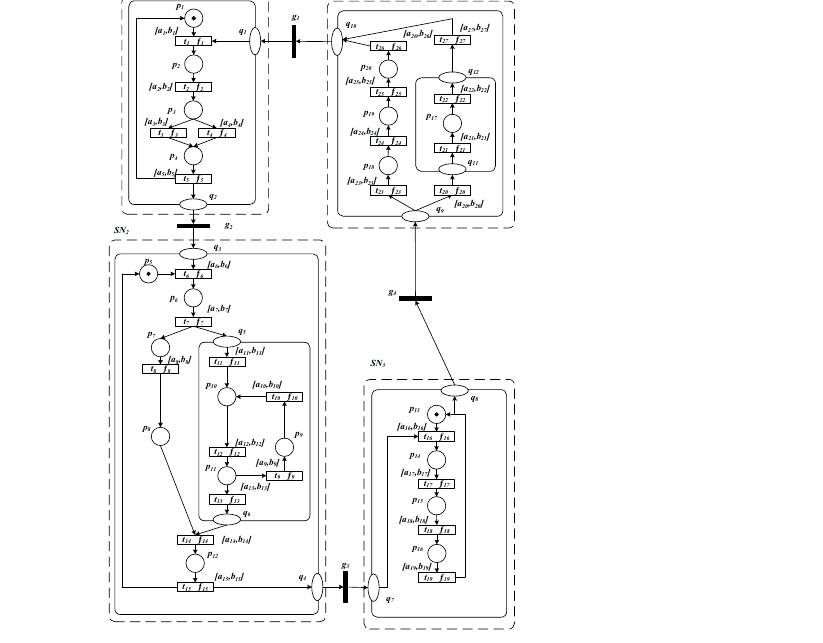
Figure 6. Σ (cid:2869) = {𝑁 (cid:2869) , 𝐹 (cid:2869) ,𝐺 (cid:2869) , 𝑀 (cid:2869) } obtained using the Q-type internal subnet reduction rule. Note that, the boundedness and liveness of the OOPRES net system Σ = {𝑁, 𝐹, 𝐺, 𝑀} , Σ (cid:2869) = {𝑁 (cid:2869) , 𝐹 (cid:2869) , 𝐺 (cid:2869) , 𝑀 (cid:2869) } and Σ (cid:2870) = {𝑁 (cid:2870) , 𝐹 (cid:2870) , 𝐺 (cid:2870) , 𝑀 (cid:2870) } in Figures 5–7 can also be veri fi ed by the modeling tool software Tina 3.7.0. (Tina 3.7.0 is a simulation tool used only for simulation analysis and viewing property analysis results.) The veri fi cation of boundedness and